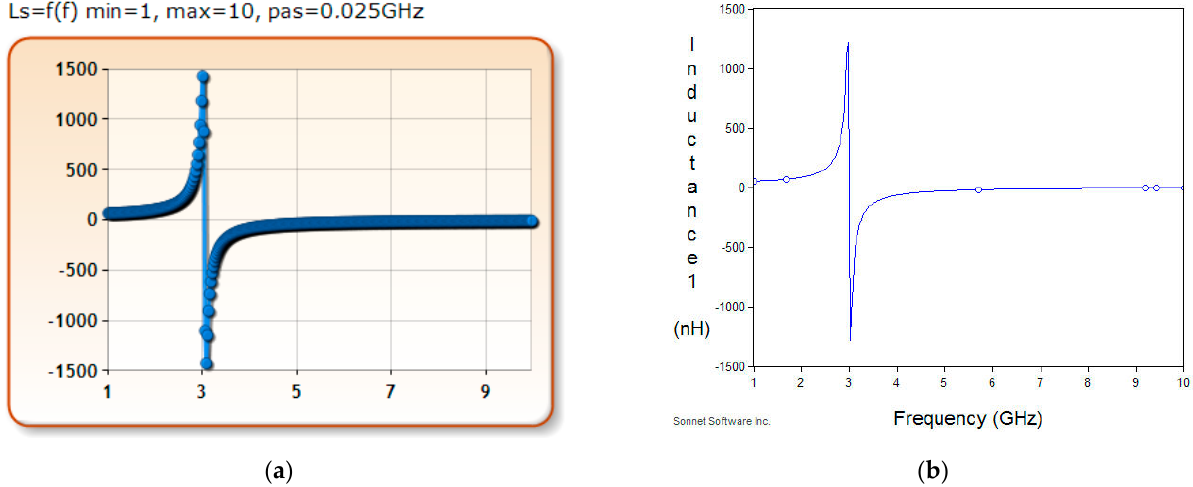
Figure 4. Inductance variation, in terms of frequency for the square spiral inductor with 16 turns obtained by: ( a ) ABSIF software program; ( b ) Sonnet Lite TM .